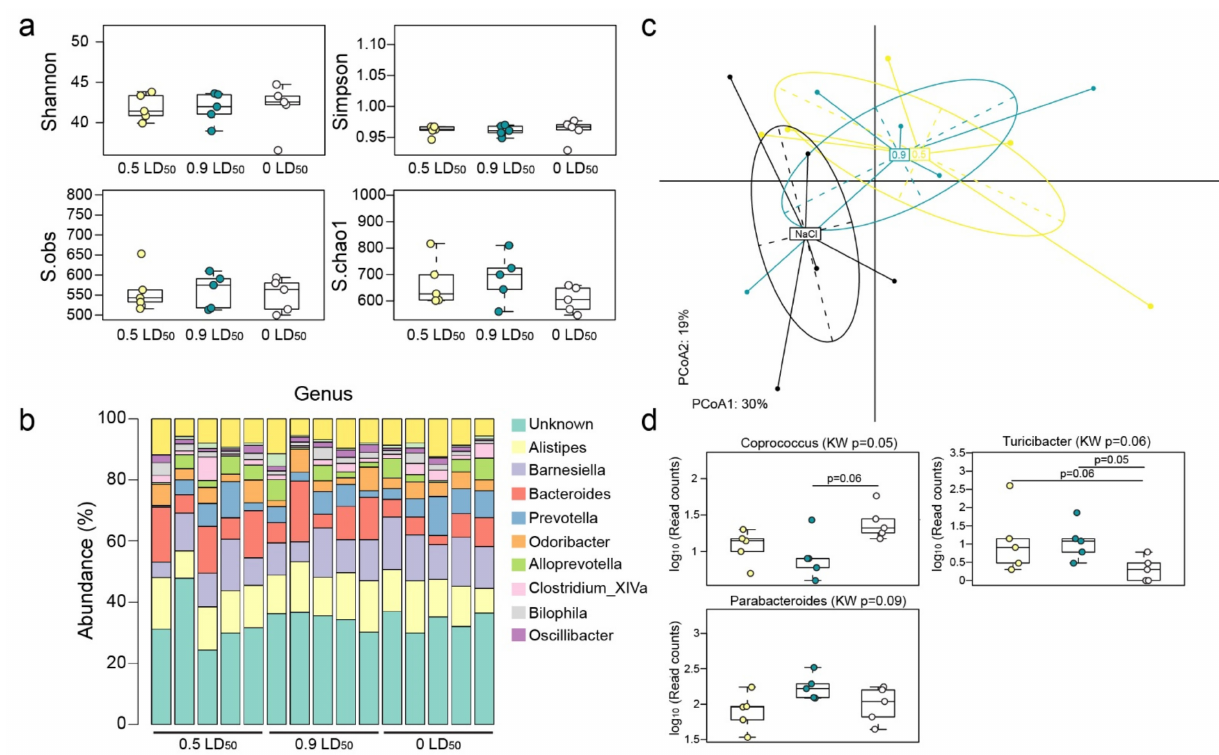
Figure 8. Mice exposed to NIMP harbor slight modifications in their gut microbiota composition 6 months after exposure. ( a ) Gut microbiota diversity was not affected by NIMP exposure. Microbial diversity and richness indexes were computed on the OTU abundance table. No difference was noted for these indexes between groups. ( b ) Overview of the gut microbiota composition at the genus level. Alistipes, Barnesiella, Bacteroides, Prevotella, Odoribacter, Alloprevotella, Clostridium_XIVa, Bilophila and Oscillibacter were the most abundant genera identified from mice gut microbiota. ( c ) NIMP exposure had a moderate impact on mice gut microbiota composition. Two-dimensional principal coordinates analysis was performed using the Bray–Curtis distances computed on the OTU abundance table. The total inertia explained (PCoA1 and PCoA2 axes) accounted for 49%. The CTL mice centroid (average microbiota profile) clustered away from both doses of NIMP-treated groups (0.5 LD50 in yellow and 0.9 LD50 in blue). This observation suggests that both doses of NIMP intoxication have a long-lasting effect on gut microbiota composition up to 6 months post- treatment. ( d ) Several gut bacterial genera display a shifted abundance following NIMP treatment. Differences in genus abundance between groups were assessed using the Kruskal–Wallis rank sum test ( p ≤ 0.1) followed by a post hoc Dunn’s all-pairs rank comparison test. Three genera harbored a shifted abundance following NIMP exposure. In comparison to CTL mice, the 0.5 LD50 and 0.9 LD50 mice groups had a lower abundance of Coprococcus ( p ≤ 0.05). The Turicibacter level increased in both 0.5 LD50 and 0.9 LD50 mice groups in comparison to the CTL group ( p ≤ 0.06). Parabacteroides was slightly increased in the 0.9 LD50